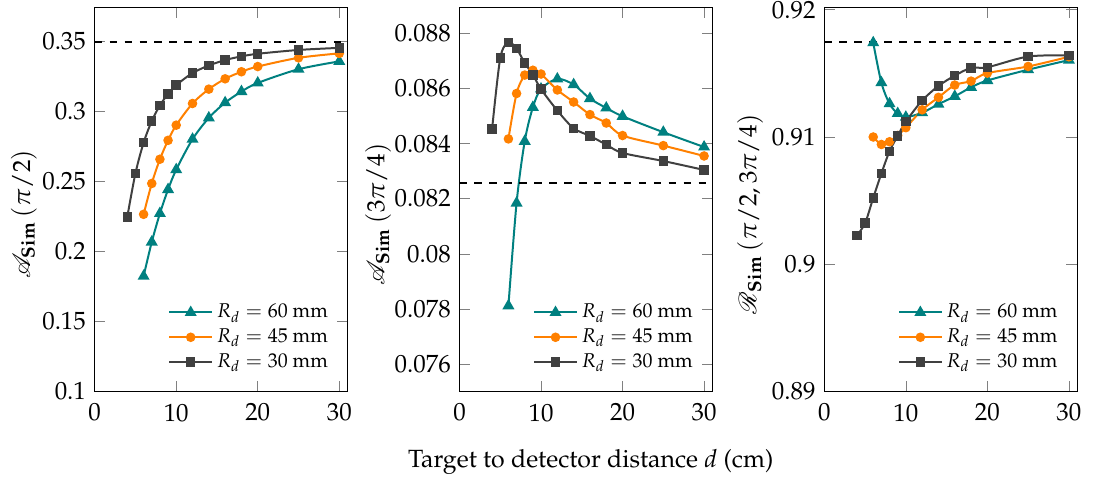
Figure 13. The same as Figure 4 for the quadrupole transition with a spin sequence of 5